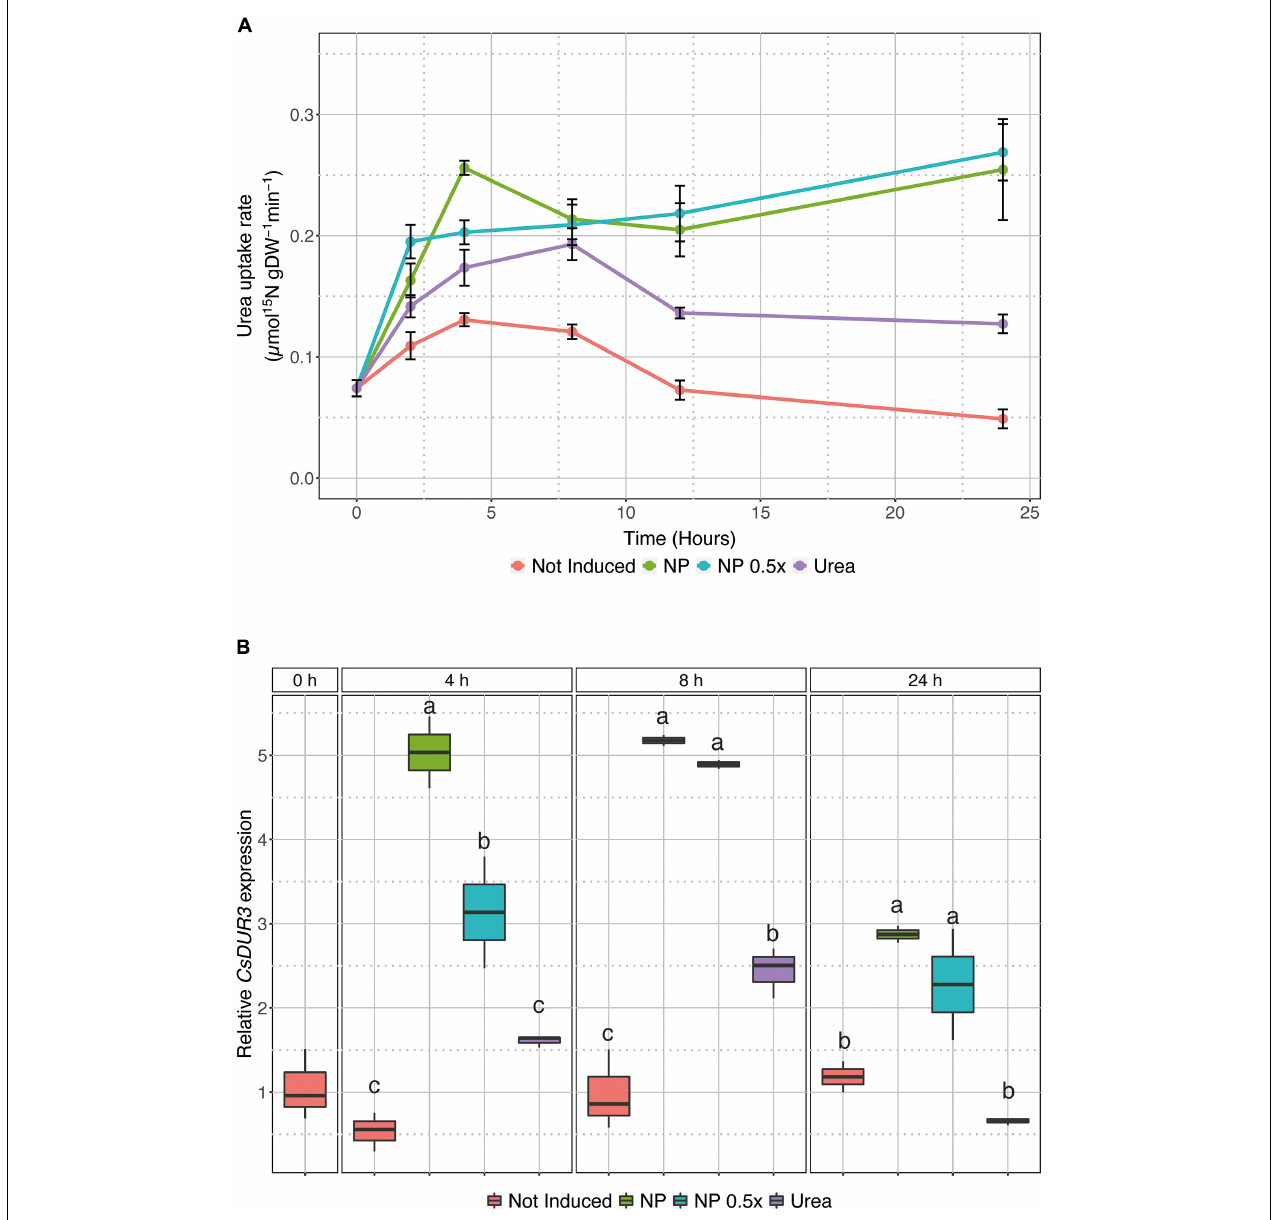
FIGURE 1 | Urea uptake in intact cucumber roots. (A) High-affinity urea uptake rate in cucumber roots either not treated (not induced) or treated with 1 mM urea, NP. or NP.5 × . Uptake rates were determined by placing the seedlings in 200 µ M 15 N-labeled urea solution for 7 min. Data are the means ( ± SE) of three independent biological replicates; each biological replicate was obtained by pooling five independent plants. The statistical significance of the whole dataset has been tested by two-way analysis of variance (ANOVA) test (Time p < 0.05, Treatment p < 0.001, Time × Treatment p < 0.001), whereas the difference between treatments within each time point was tested by one-way ANOVA with Tukey post hoc tests ( P < 0.001), and the results are reported in Supplementary Table 1 . (B) Time course expression analysis of CsDUR3 in cucumber roots either not treated (not induced) or treated with 1 mM Urea, NP, or NP.5 × . CsDUR3 expression levels were assessed by qRT-PCR; data have been normalized to two internal controls, ubiquitin elongation protein, and elongation factor 1- α tubulin. The relative expression ratios were calculated using not-induced roots sampled before the treatments (0 h), which were set with a value of 1. Different letters within a time-point indicate significantly different values as determined by one-way ANOVA with Tukey post hoc tests ( P <